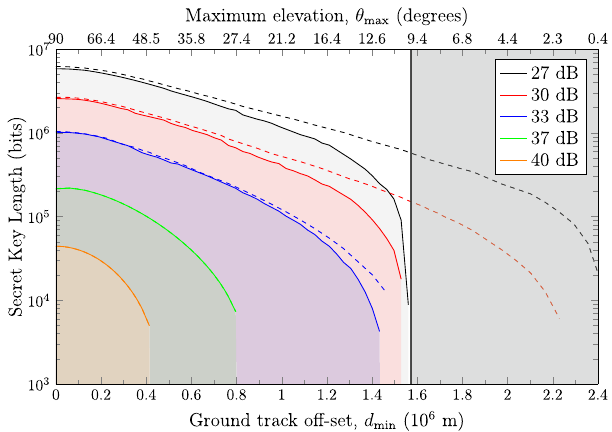
0.5%. The key generation footprint is given by the maximum d